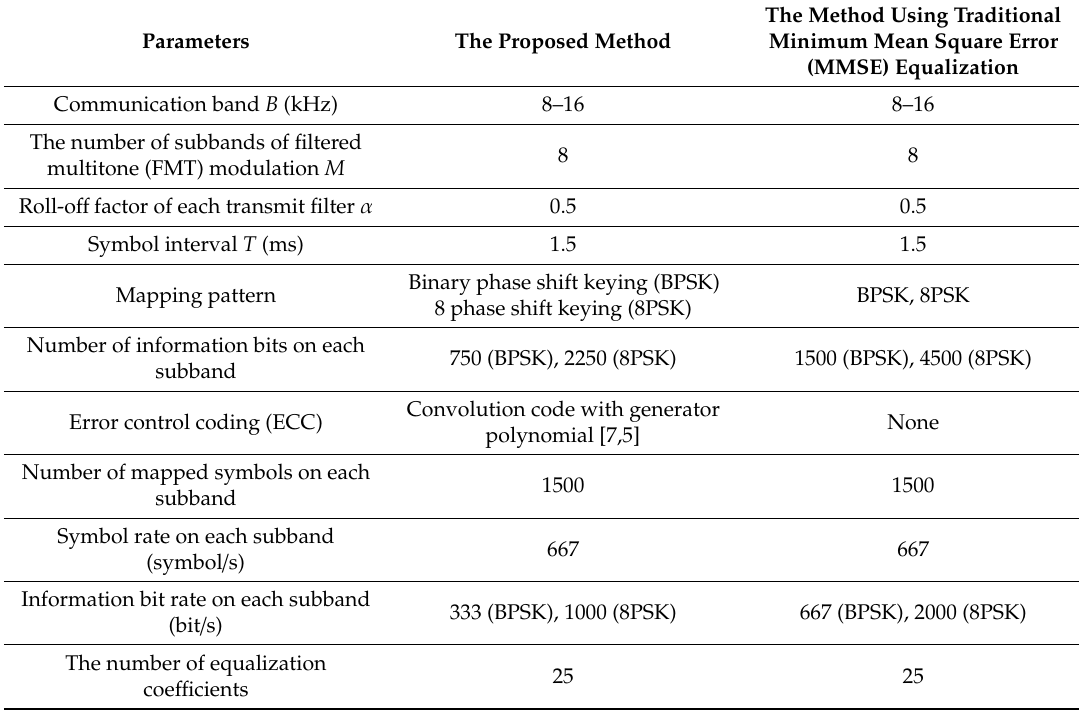
Table 1. Parameters for simulation